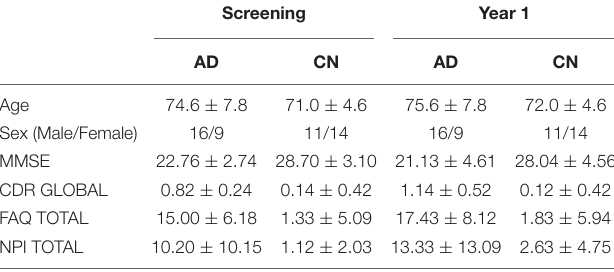
TABLE 1 | Demographic table.